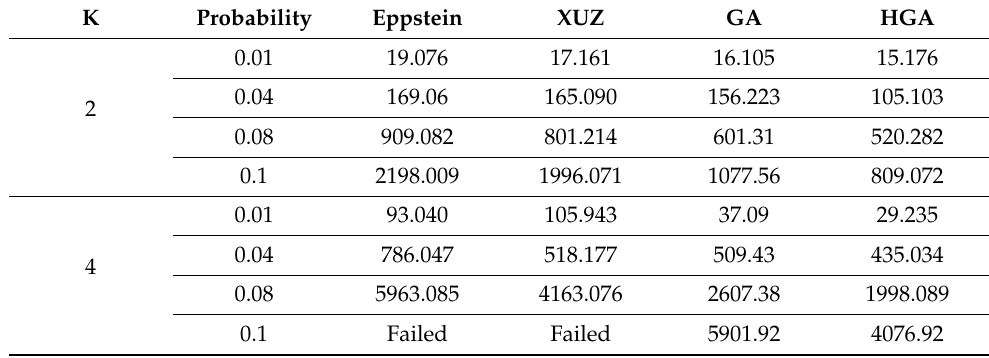
Table 2. Run time of counterexample generation.